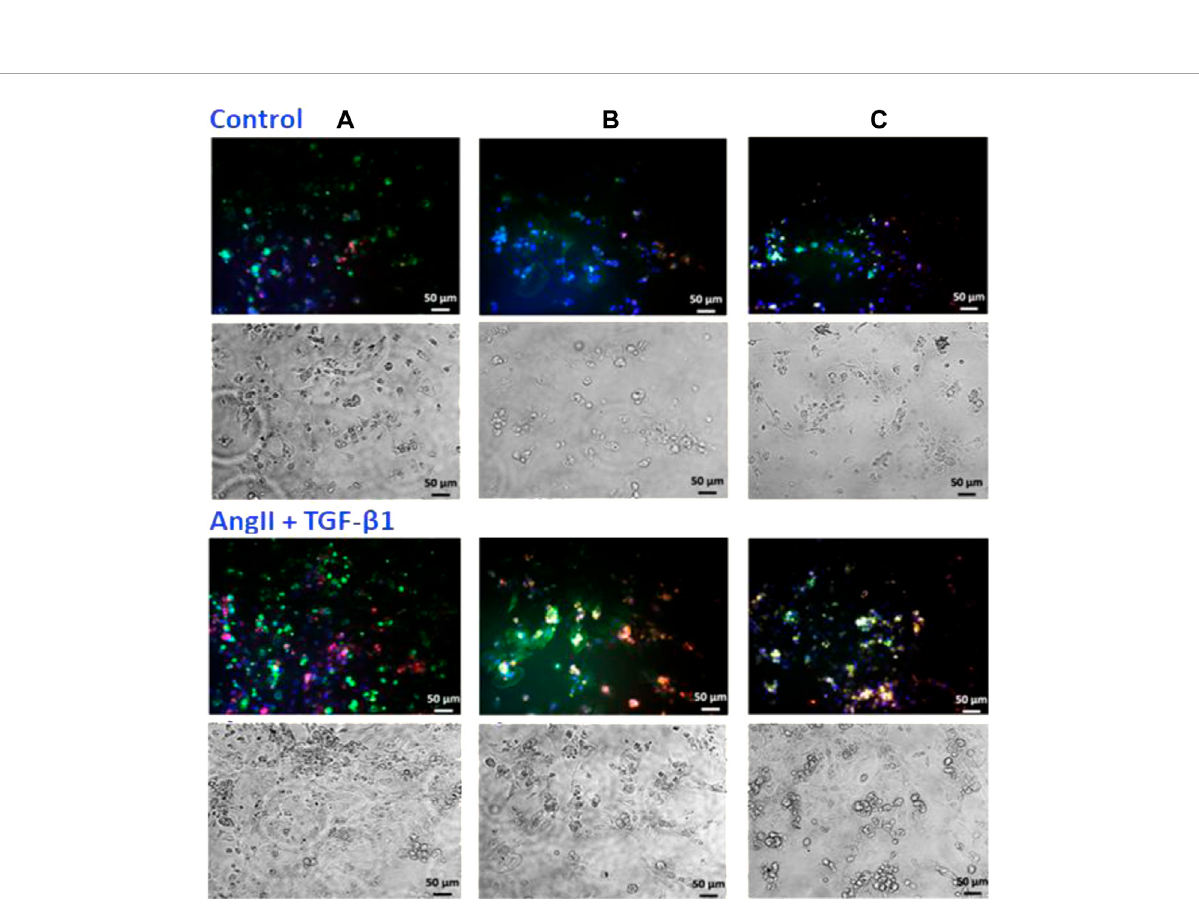
FIGURE 4 Immuno fl uorescence localization of (A) ANF (green) and MIF (red), (B) cTnI (green) and COL1A1 (red), and (C) α -SMA (green) and Cx43 (red) proteins in hiPSC-CMs incubated with 200 nMAngII + 10 ng/mLTGF- β 1 for 48 hours and unstimulated hiPSC-CMs taken as control cells. Nuclei were stained with DAPI and shown in blue fl uorescence. Five independent experiments were conducted in duplicate and fi ve different microscopic fi elds for each tested molecule were analysed. The images were quanti fi ed using the ImageJ